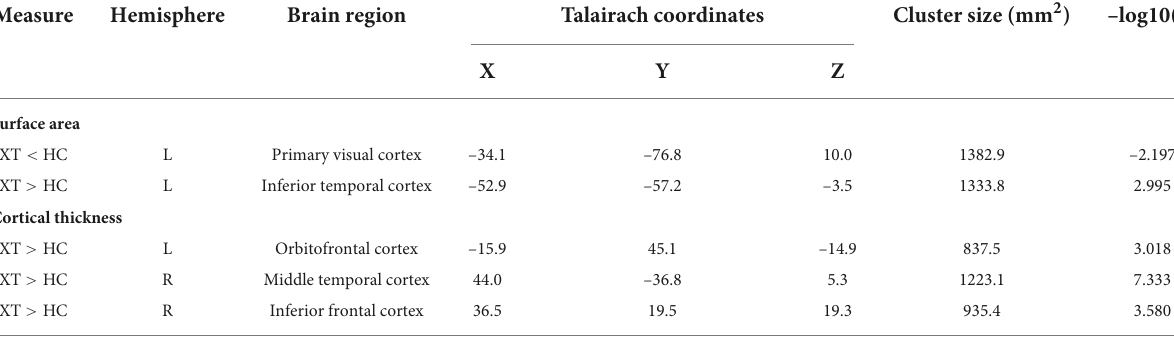
TABLE 2 Brain regions with altered surface area and cortical thickness in IXT compared to HC.